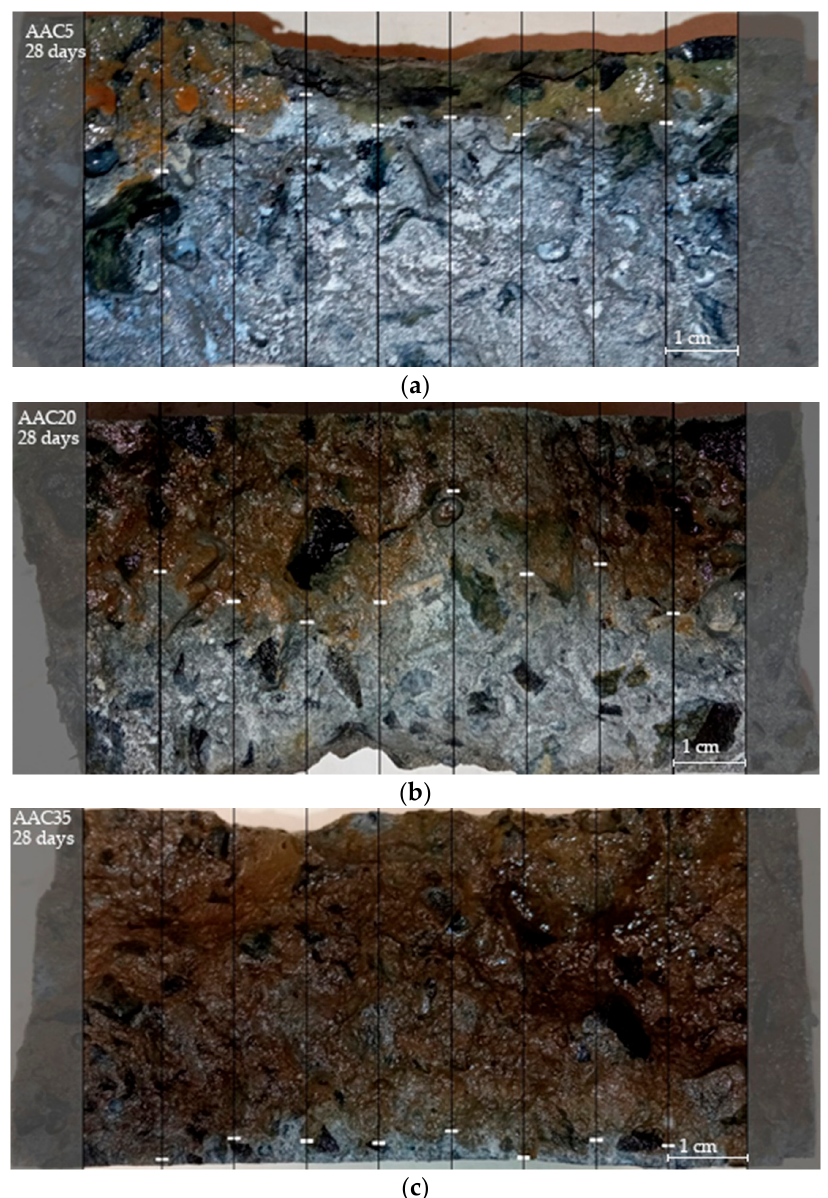
Figure 5. Chloride penetration depths of alkali-activated concretes after 28 days: ( a ) AAC5; ( b ) AAC20; ( c ) AAC35.